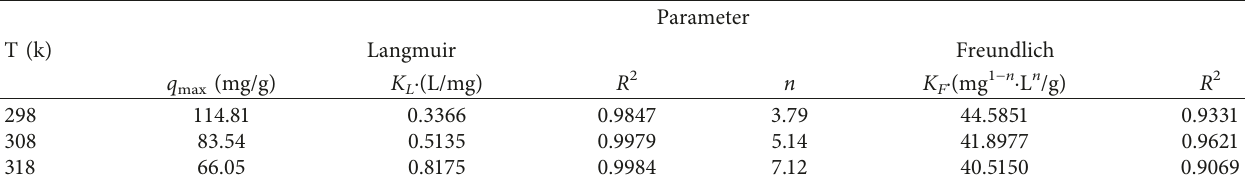
Table 2: Parameters of isotherm for Cr (VI) removal by